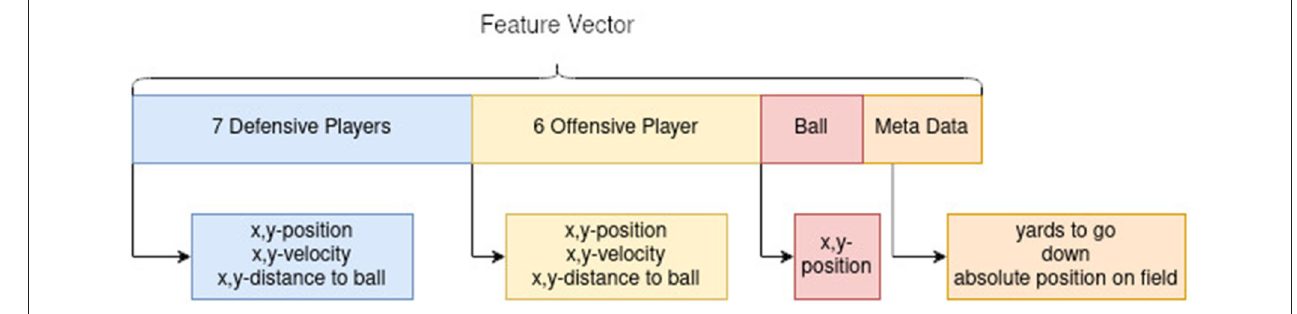
FIGURE 3 | Feature vector ghosting model.